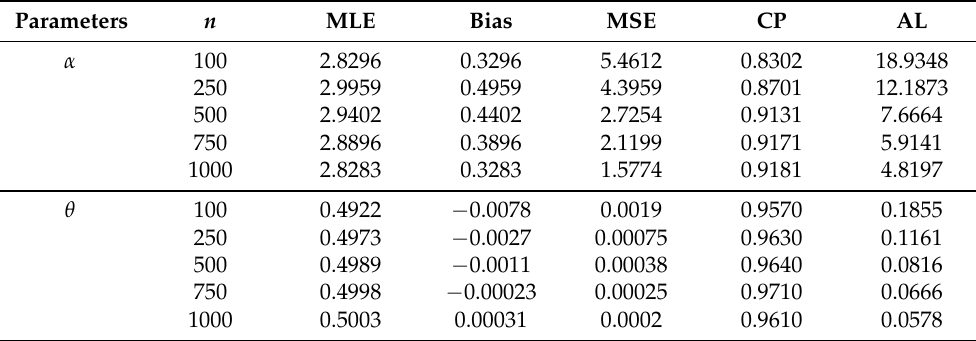
Table 2. The simulation results for ( α = 2.5, θ =